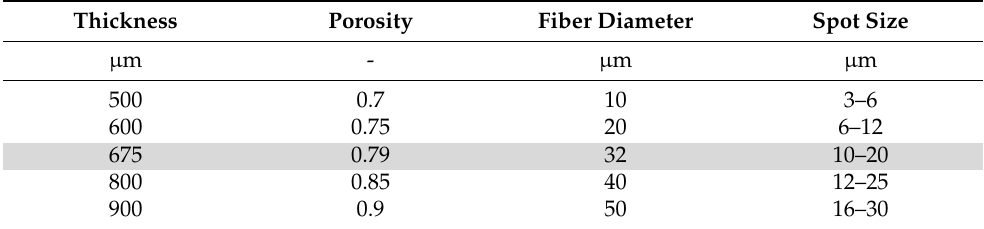
Table 4. Values for 3D model